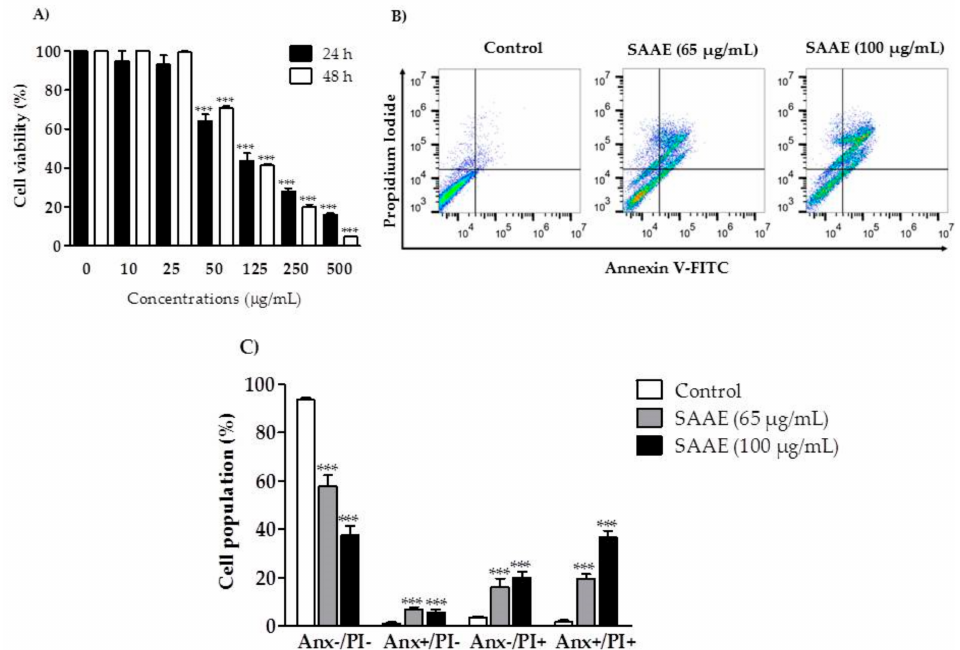
Figure 7. Viability and cell death profiles of the B16F10Nex-2 melanoma cell line after treatment with different concentrations of the SAAE. ( A ) Cell viability versus concentration (10–500 µ g/mL) after 24 and 48 h of treatment. ( B ) Diagram of flow cytometry of cells stained with Annexin V–fluorescein isothiocyanate (FITC) and propidium iodide (PI) after a 24 h of treatment with the SAAE (65 and 100 µ g/mL). The lower left quadrant (Anx − /PI − ) represents viable cells, the lower right quadrant (Anx + /PI − ) represents apoptotic cells, the upper left quadrant (Anx − /PI + ) represents necrotic cells, and the upper right quadrant (Anx + /PI + ) represents late apoptotic cells. ( C ) Percentage of dead cells assessed in the diagram corresponding to concentrations of 65 and 100 µ g/mL. Data are expressed as the mean ± SEM ( n = 3) in duplicates. *** p < 0.0001, compared with the untreated control